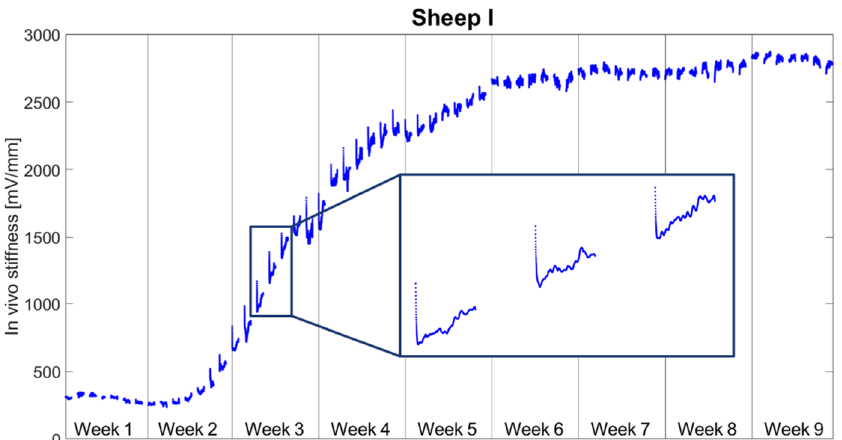
Figure 4. Continuous measurements of the tissue stiffness for Sheep I. Each data point represents one cycle; therefore, each segment shows measurements from 9.00 am to 9.00 pm.